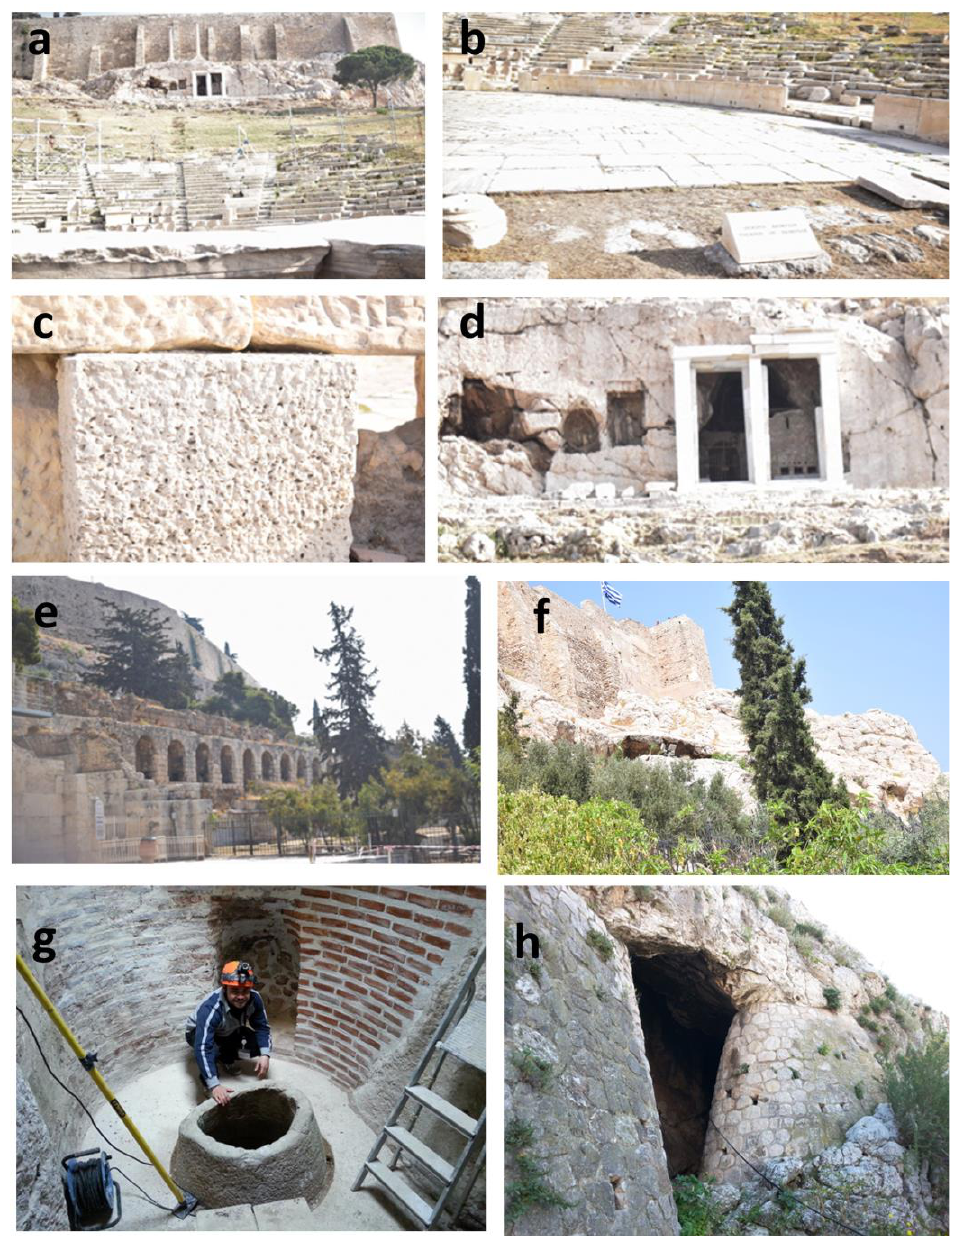
Figure 8. (a ) and ( b ) GS2: Theater of Dionysus; ( c ) Aktitis Lithos; ( d ) GS3: The Choragic Monument of Thrasyllos and ( e ) GS4: Stoa of Eumenes; ( f ) Sanctuary of Aglauros; ( g ) GS7: Klepsydra; ( h ) GS8: Mycenaean Fountain; (photos by Fani Tripolitsiotou and Panos Karoutsos).